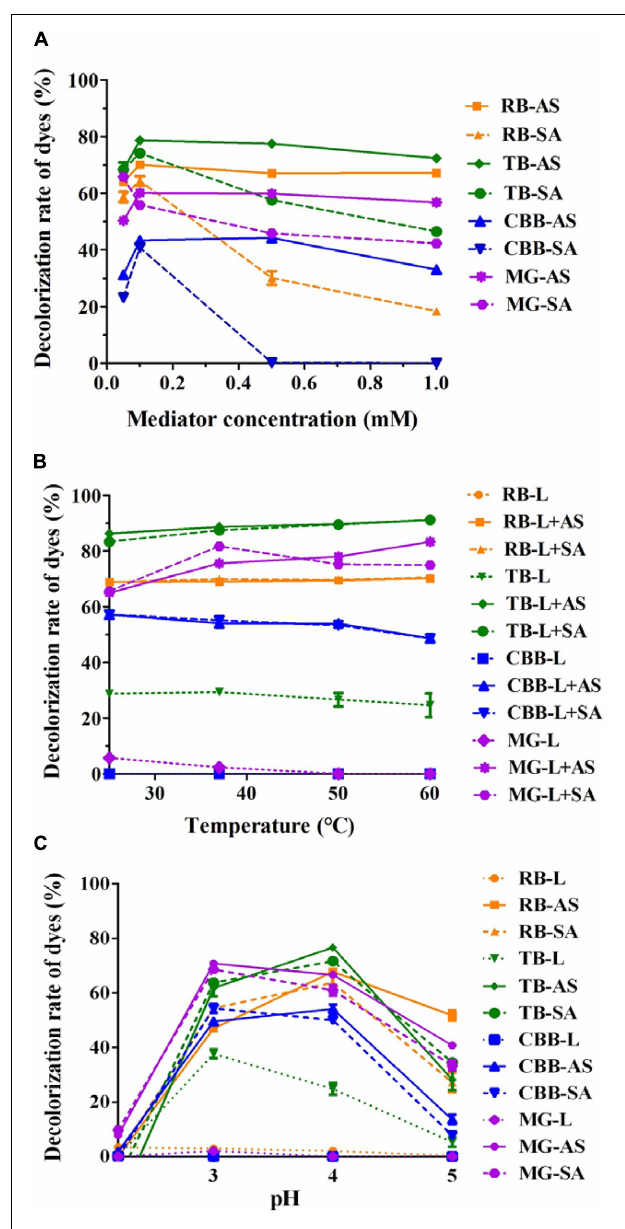
FIGURE 5 | Optimal LMS reaction conditions for dye decolorization. (A) Mediator concentration; (B) temperature; (C)